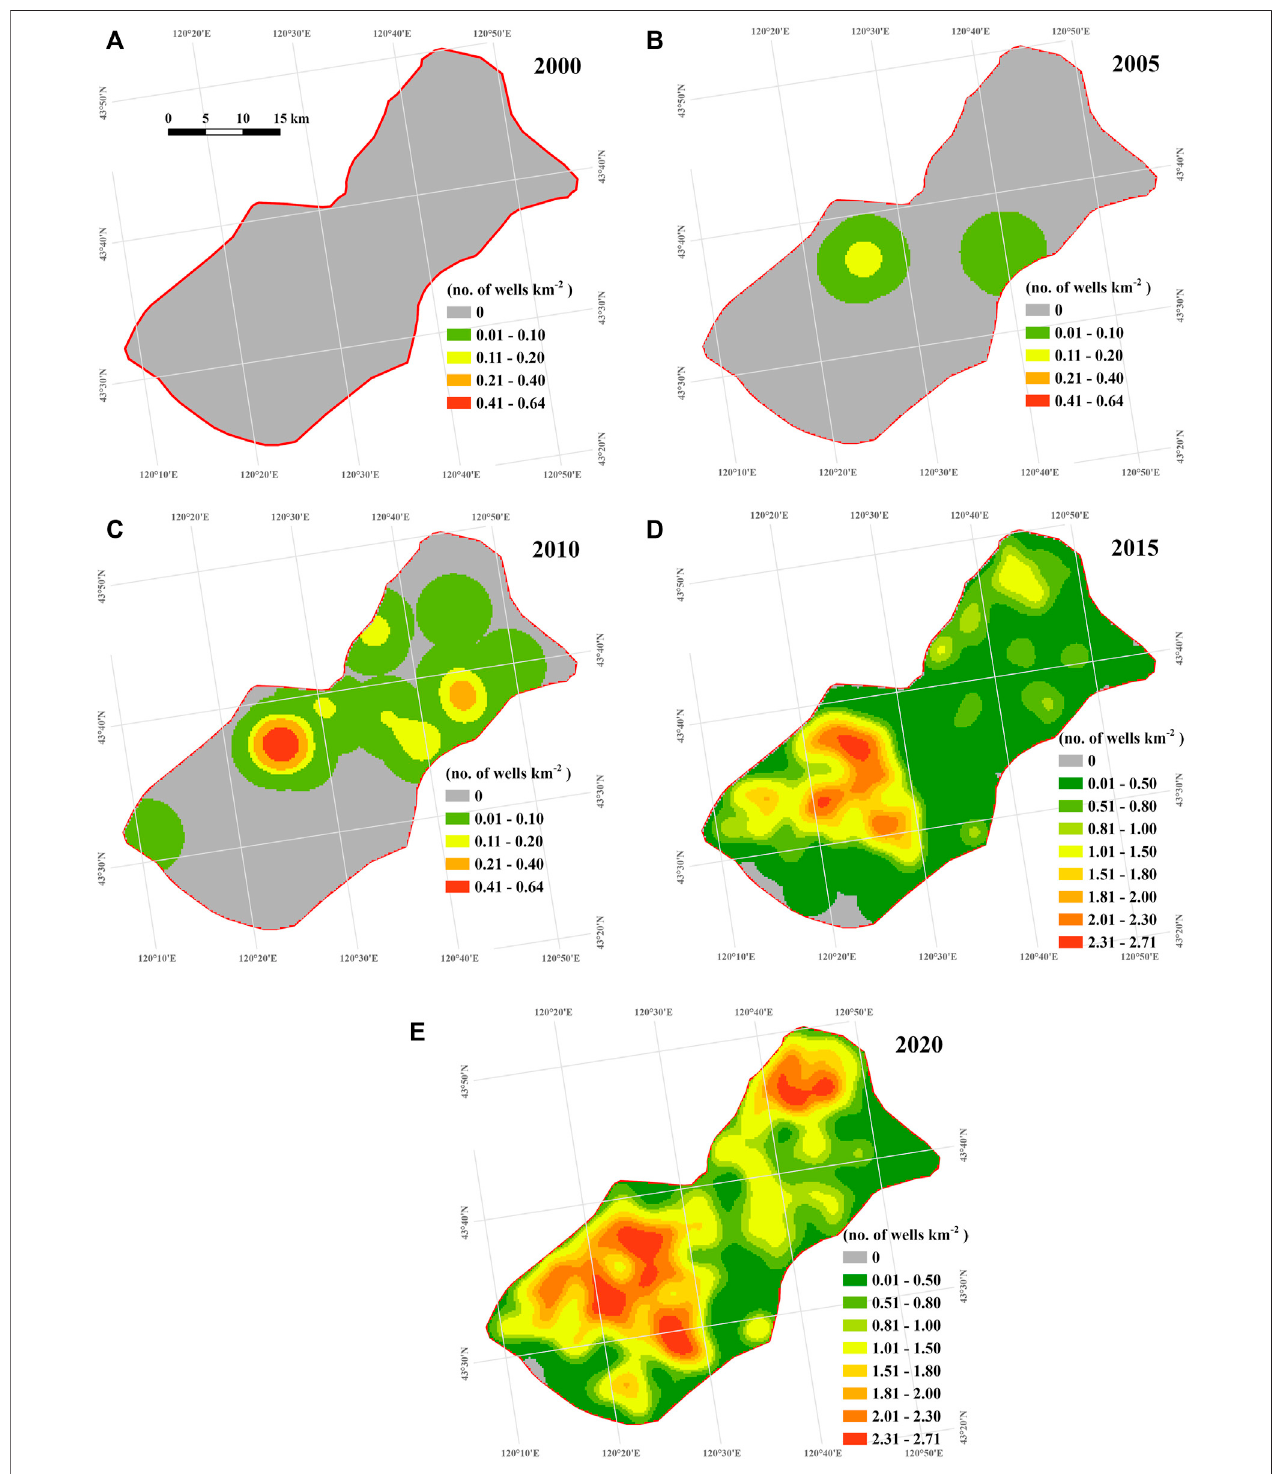
FIGURE 2 | Kernel density estimates for the center-pivot irrigation wells. (A) 2000, (B) 2005, (C) 2010, (D) 2015, and (E) 2020.